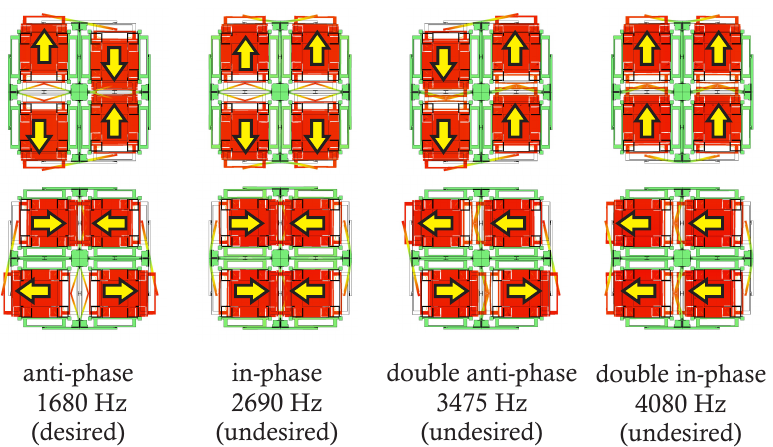
Figure 3. Eigen-frequency simulations of a Quad Mass Gyroscope (QMG), showing the four degener- ate modes of vibration and the frequency of each resonance mode. The vibrational modes are ordered to place the desired anti-phase mode at the lowest frequency [31].